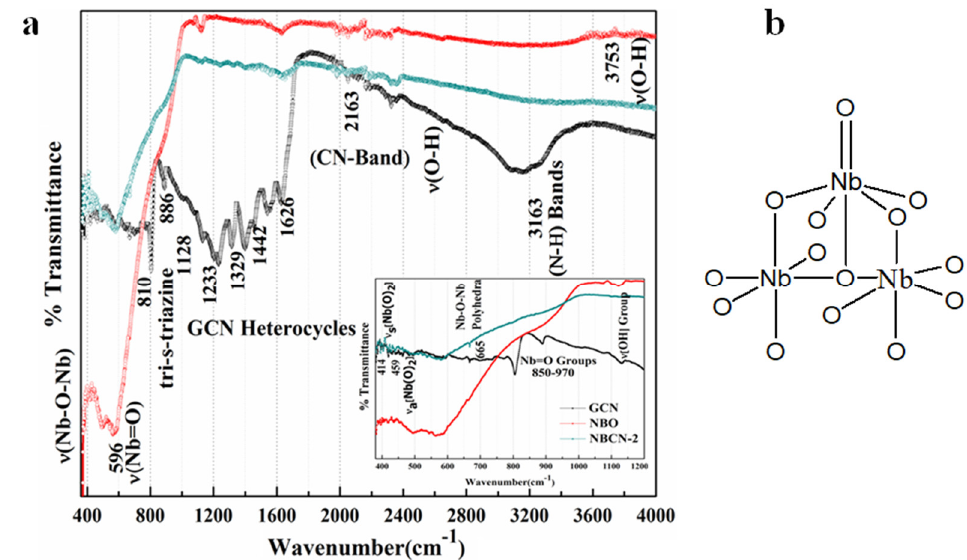
Figure 5. ( a ) FTIR spectra of NBO, GCN and NBCN-2 and ( b ) Highly and slightly distorted NbO 6 octahedra coexist in the structure.